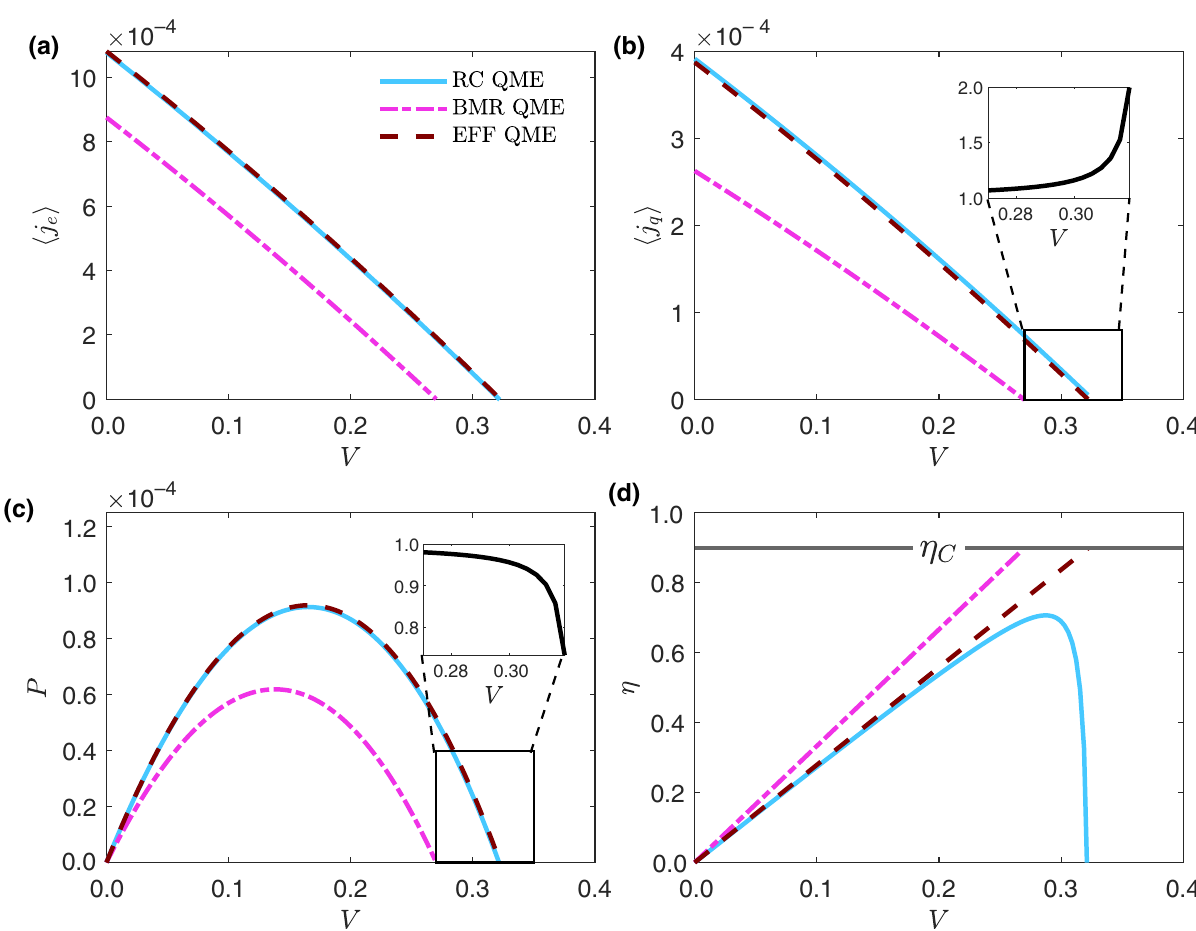
FIG. 10. A phonon-assisted double-quantum-dot thermoelectric power generator. (a) The mean charge current from the left lead (positive) toward the system. (b) The mean heat current from the left reservoir. (c) The power output of the generator, which is given by the charge current times voltage. (d) The thermoelectric efficiency, compared to the Carnot bound η C . The insets in (b) and (c) present the ratio of currents (RC-QME result over EFF-QME) in the vicinity of the stopping voltage. The parameters are the same as in Fig. 9, with λ = 17.3 and μ L = − 0.3, while μ R is